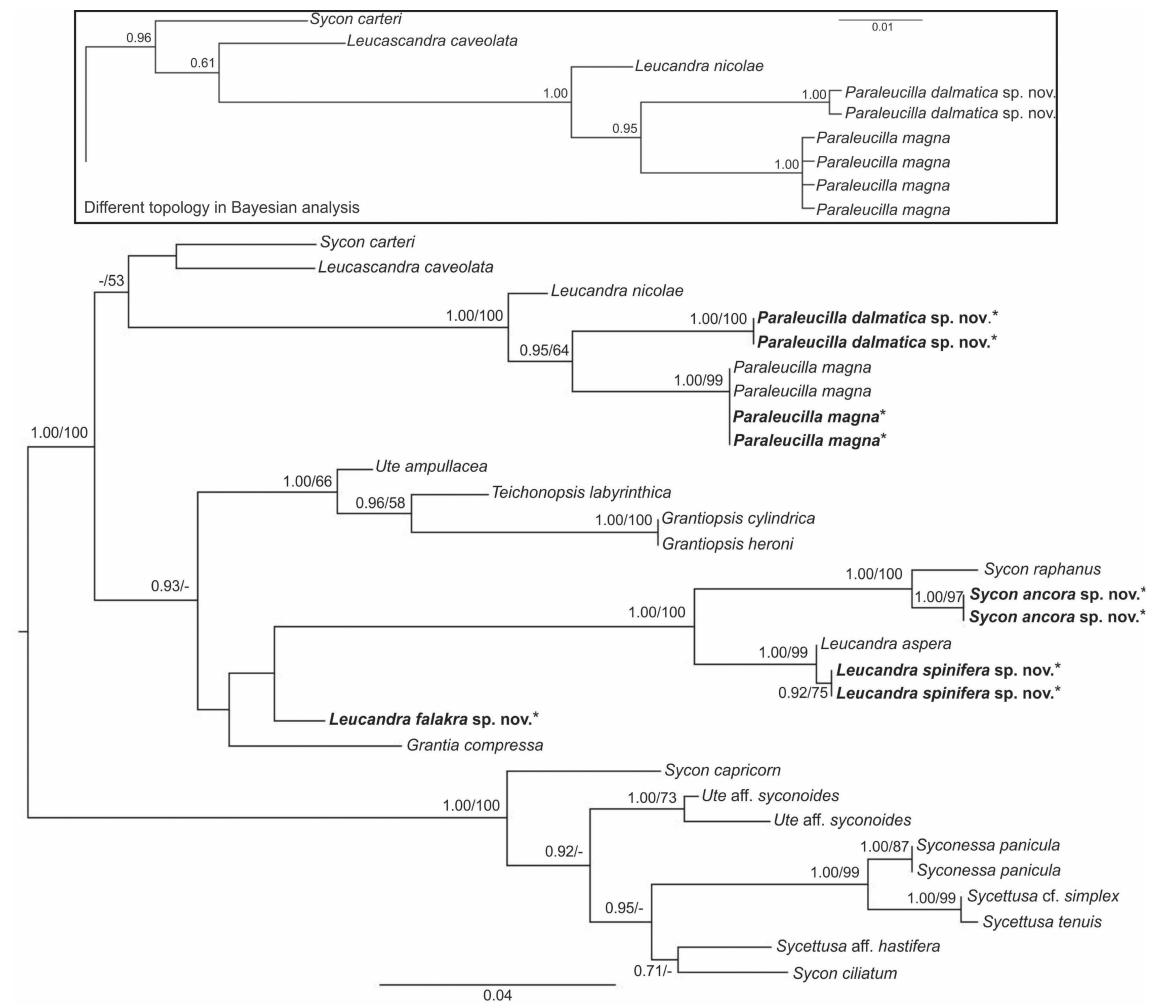
Fig. 19. Maximum likelihood tree based on partial 28S rDNA sequences of Calcaronea. Bayesian posterior probabilities (PP) and bootstrap values (BS) are given near the branches (PP/BS; when >0.50). Adriatic specimens are written in bold. Adriatic specimens obtained in this study are marked with an asterisk. The detached tree shows the only difference in the topology of the ML and Bayesian